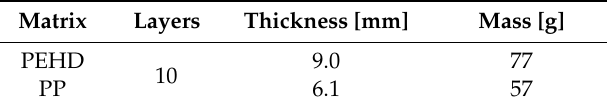
Table 1. Types of manufactured ballistic panels.